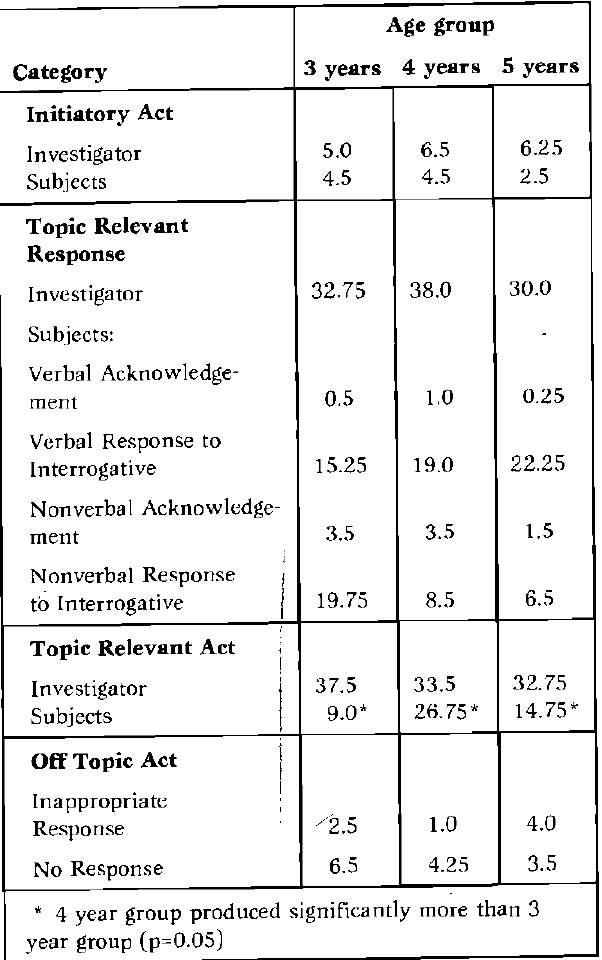
Table 2: Mean frequency scores per age group for the categories of topic